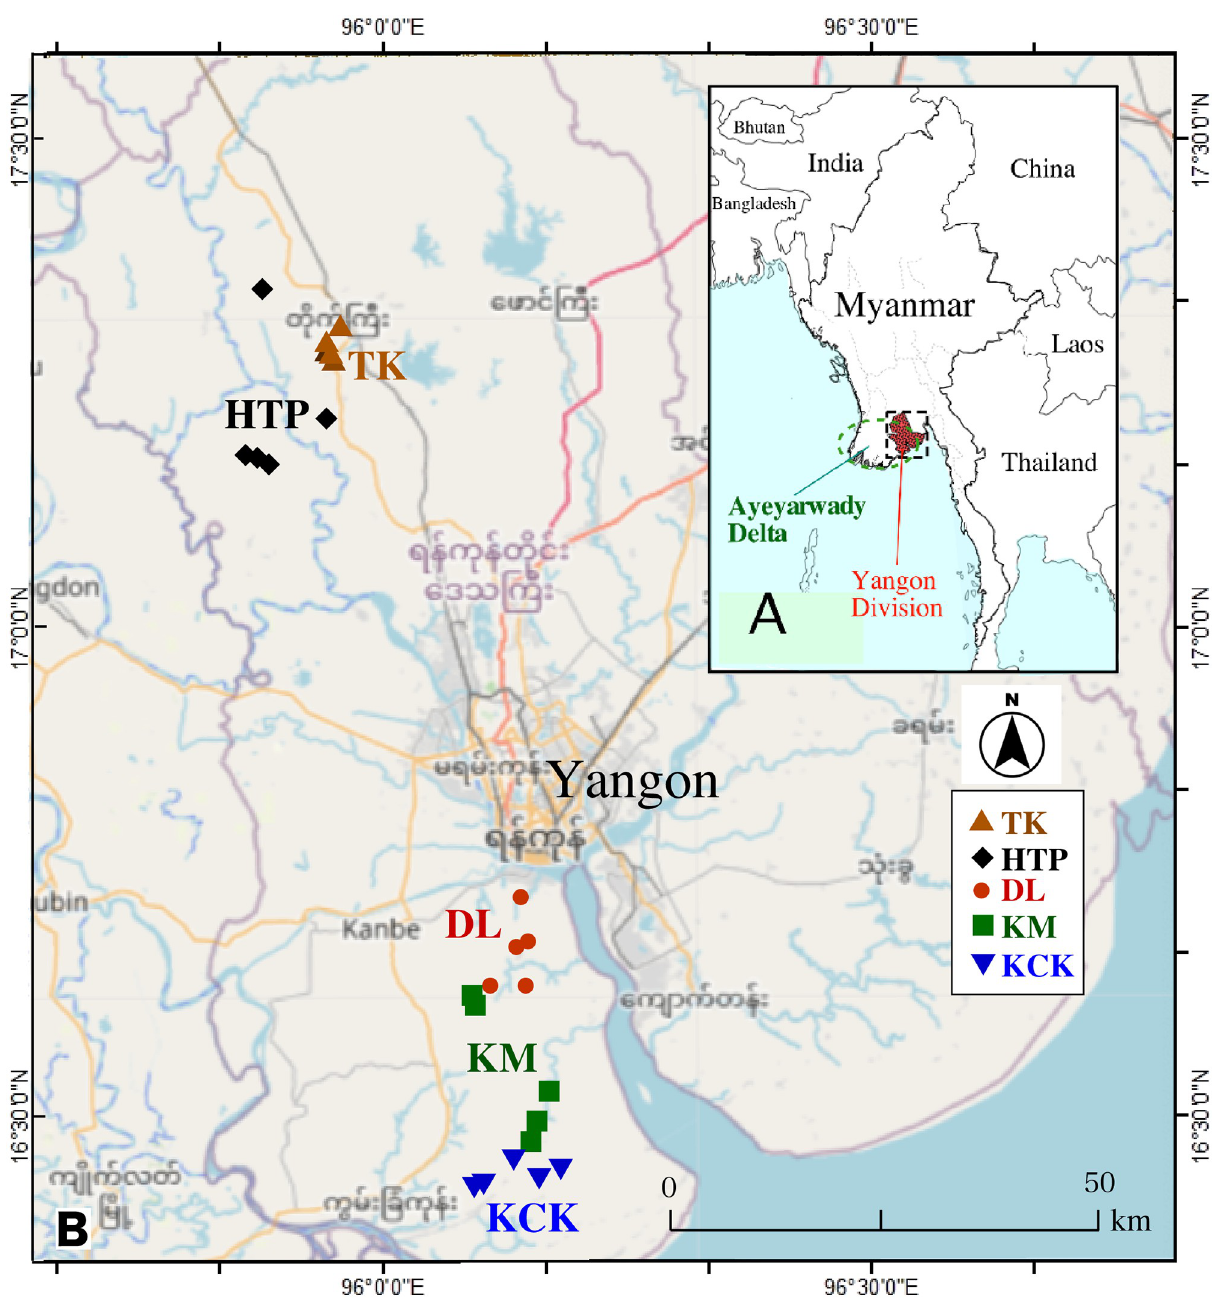
Fig 1. Maps of sampling areas in this study. A) Map of Myanmar and Yangon division (red full hatched area). B) The rice sampling points in five townships on the geographical map. The township names are as follows: Dala (DL), Taik Kyi (TK), Htan Ta Pin (HTP), Kaw Mhu (KM), and Kon Chan Kone (KCK). Figure made with 3Kaku-K company (https://www.freemap.jp/) and OpenStreetMap (https://www.openstreetmap.org/)